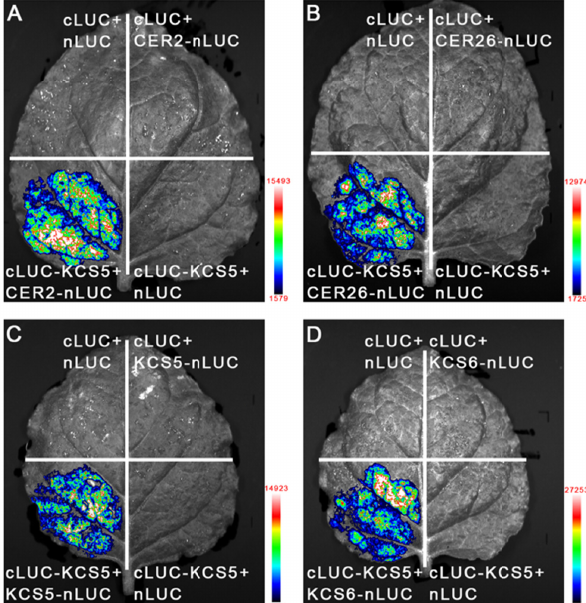
Figure 3. Interactions between KCS5 and CER2 or CER26 by BiLC experiments. Agrobacterium strain GV3101 containing different combinations ( A – D ) was transiently infiltrated into tobacco leaves. After 2–3 days, luminescence signals were captured by Tanon 5200 luminescence imaging system (Tianneng Technology Co., Ltd., Shanghai, China). The colors labeled beside the figures indicate signal